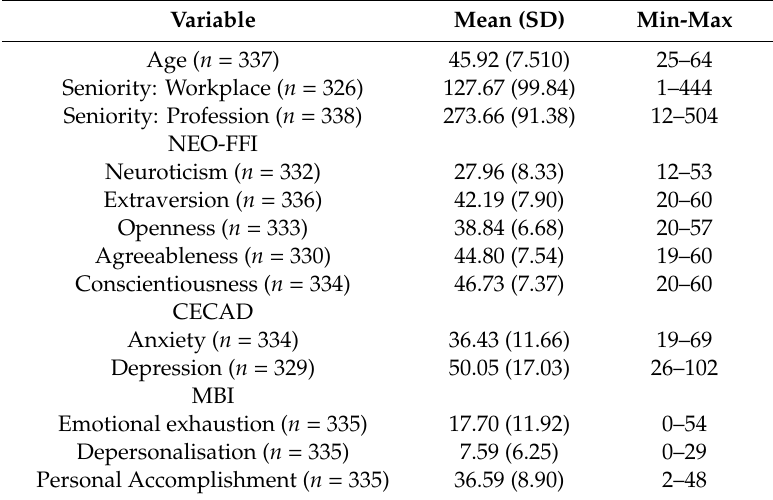
Table 2. Descriptive data for the quantitative study variables.